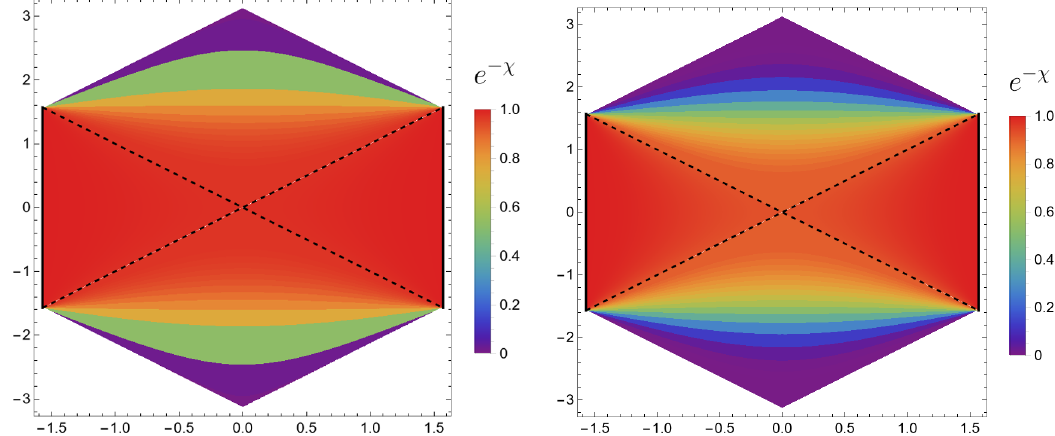
Figure 9 . Penrose diagrams for the charged solutions shown in figures 7 left, and 8